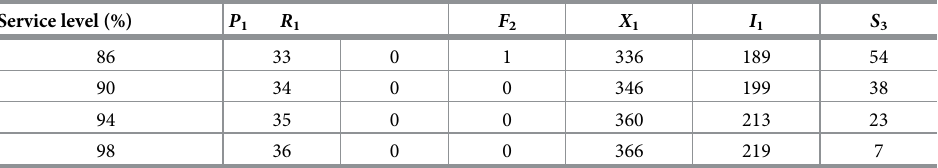
Table 12. Impact of the service level constraint respect to decision variables in Model-I. Own elaboration. Service level (%) P 1